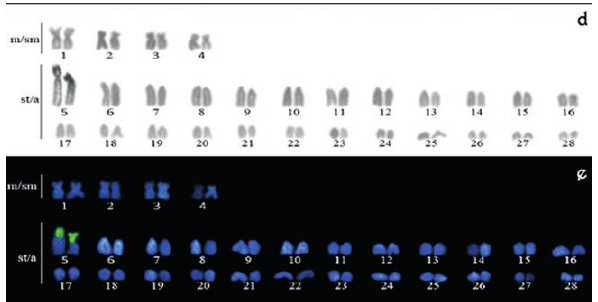
Figure 2. Karyotype of Rineloricaria pentamaculata from the Itiz stream showing: d) the heterochromatin distribution pattern after C-banding; e) CMA3/DAPI base-specific